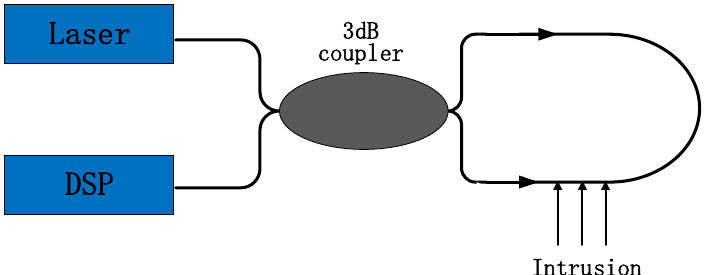
Figure 1. Schematic diagram of distributed optical fiber sensing technology based on a Sagnac interferometer.